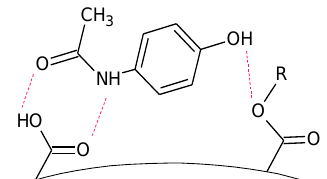
Figure 10. Scheme of possible interactions between a paracetamol molecule and an acid functional group on the polymer surface.